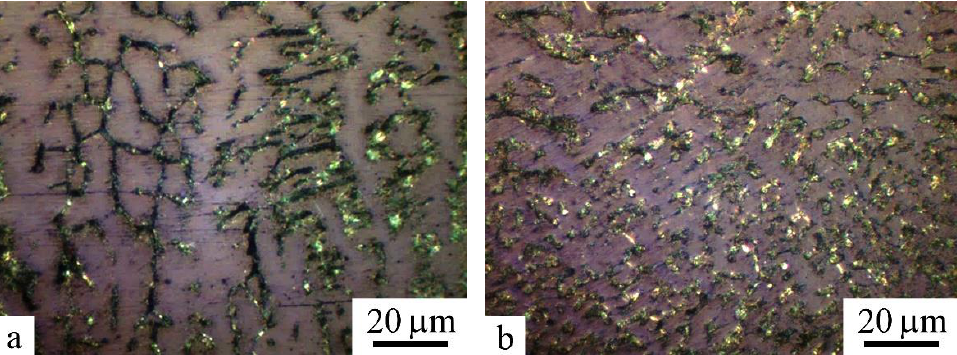
Figure 11. Microstructure inside a layer for the samples after deposition welding without ( a ) and with ( b ) layer-by-layer peening. Polarized light.